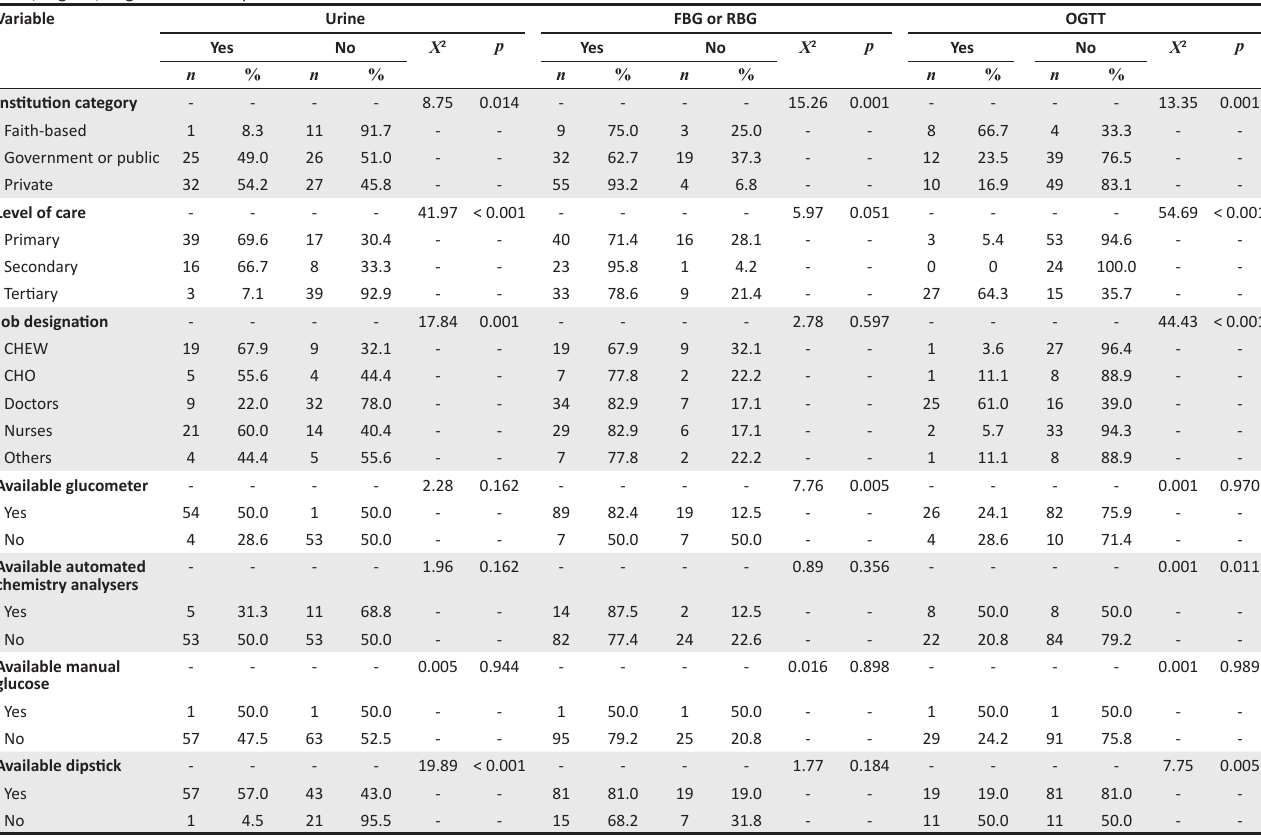
TABLE 4: Factors associated with type of diagnostic test for gestational diabetes mellitus among antenatal healthcare providers in healthcare facilities in Jos North, Plateau state, Nigeria, August 2019 to September 2019. Variable